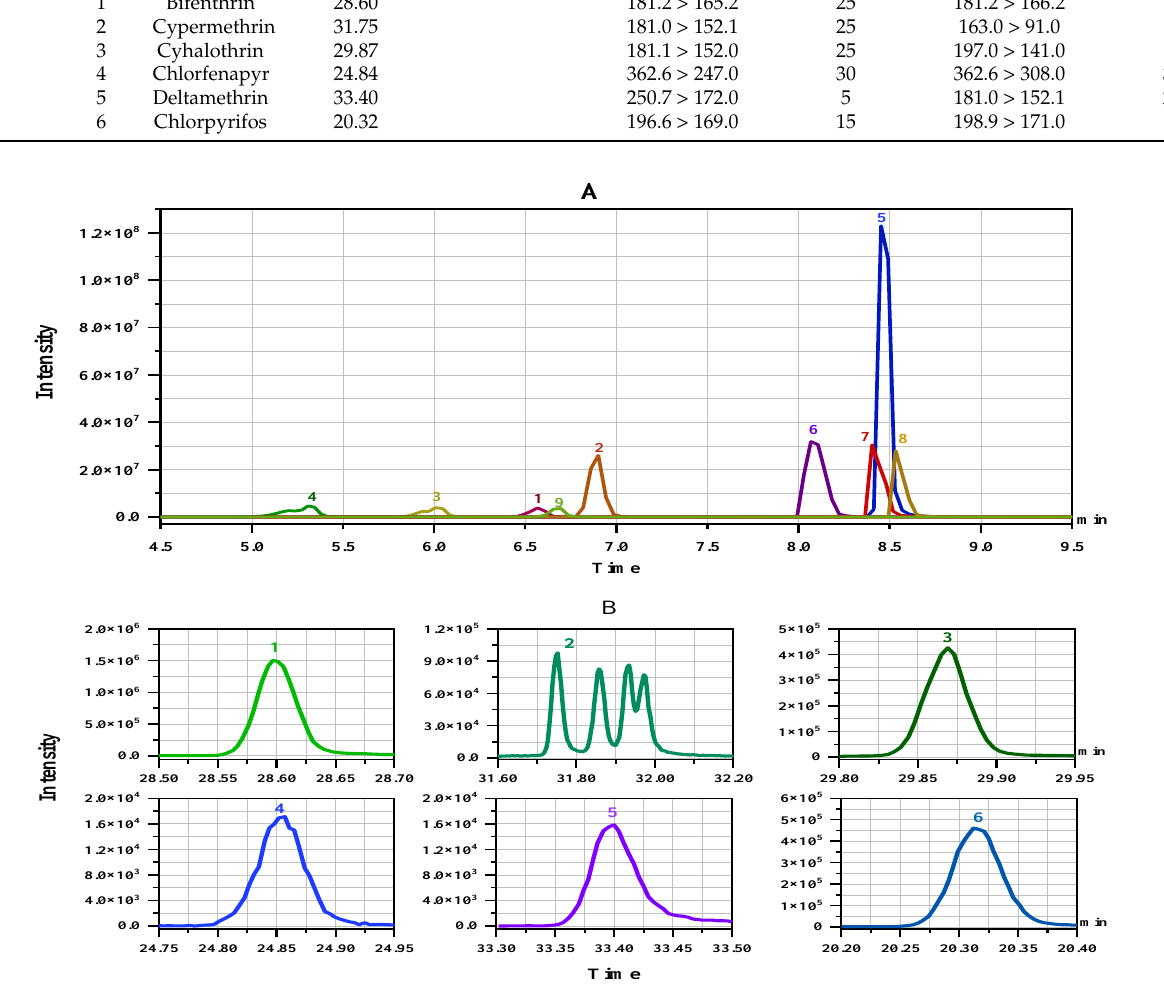
Figure 1. The representative MRM chromatograms of the 15 pesticides by LC-MS/MS ( A ) and GC-MS/MS ( B ) (The numbers correspond to those in Table